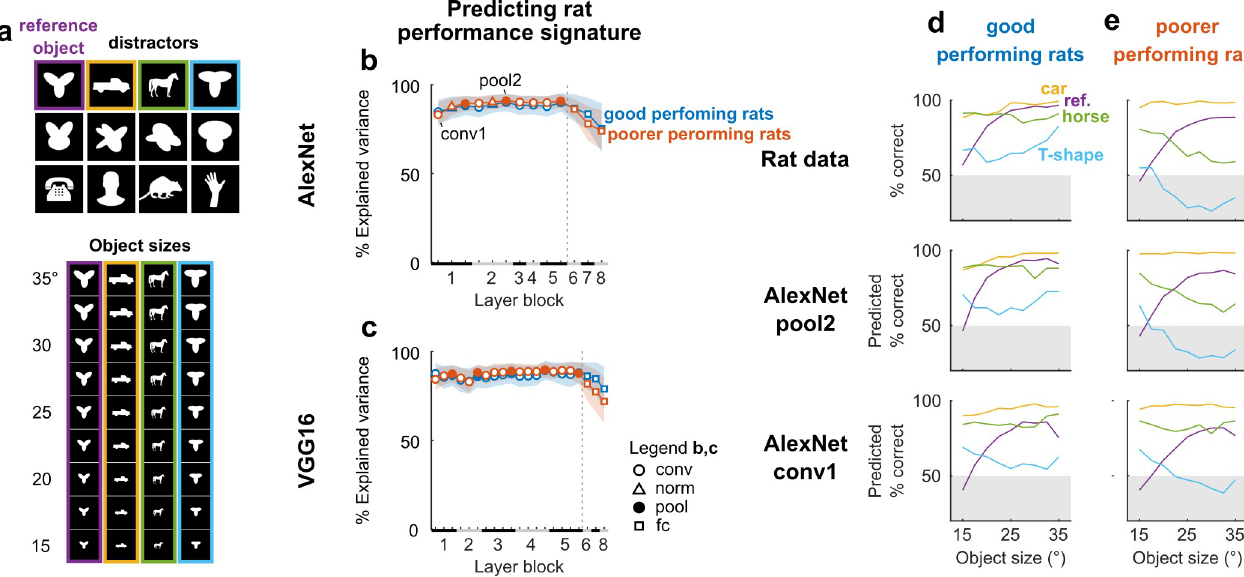
Fig 3. Stimulus-level discrimination performance signatures for objects from Djurdjevic et al. [5] map onto earliest DNN layers. ( a ) Top: the reference object (purple) and 11 distractor objects (rest) that rats were trained to discriminate in the behavioral task. For copyright reasons we do not show the stimuli from the original paper, but similar silhouette images were redrawn by hand or adapted from close-matching clip-art (https://openclipart.org/) for illustrative purposes only. For the model we did use the originals from [5]. The 3 example distractors of Fig 1 in Djurdjevic et al. [5] are highlighted in yellow, green, and light blue. Bottom: in a later phase of the experiment, the rats were trained to tolerate size changes in all objects from 15˚ to 35˚ of visual angle (here only shown for the subset of 4 objects indicated in color on the top). ( b , c ) Percentage of variance in average discrimination performance of good performing (blue) and poorer performing (red) rats, explained by each DNN layer (estimated by a linear mapping with leave-one-out cross-validation) from AlexNet (b) and VGG16 (c). The linear mapping was estimated using the data available in Figs 1 and 2 of Djurdjevic et al. [5]: all sizes of the 4 example objects indicated by purple, yellow, green, and light blue in (a), and the 30˚ size for the remaining eight objects. Black and grey bars on the X-axis indicate layer blocks and markers indicate layer types (see legend insert); the division between convolutional and fully connected layer blocks is indicated by a dashed line. Error bounds are 95% confidence intervals calculated using Jackknife standard error estimates (resampling stimuli). ( d ) Top: average discrimination performances of good performing rats, as a function of object size, for the reference object and the 3 example distractors. Middle: average predicted discrimination performances of good performing rats, based on pool2 of AlexNet, which explained the most out-of-sample variance in behavioral performance. Bottom: same as middle, but for conv1 of AlexNet. ( e ) Same as (d), but for poorer performing rats.